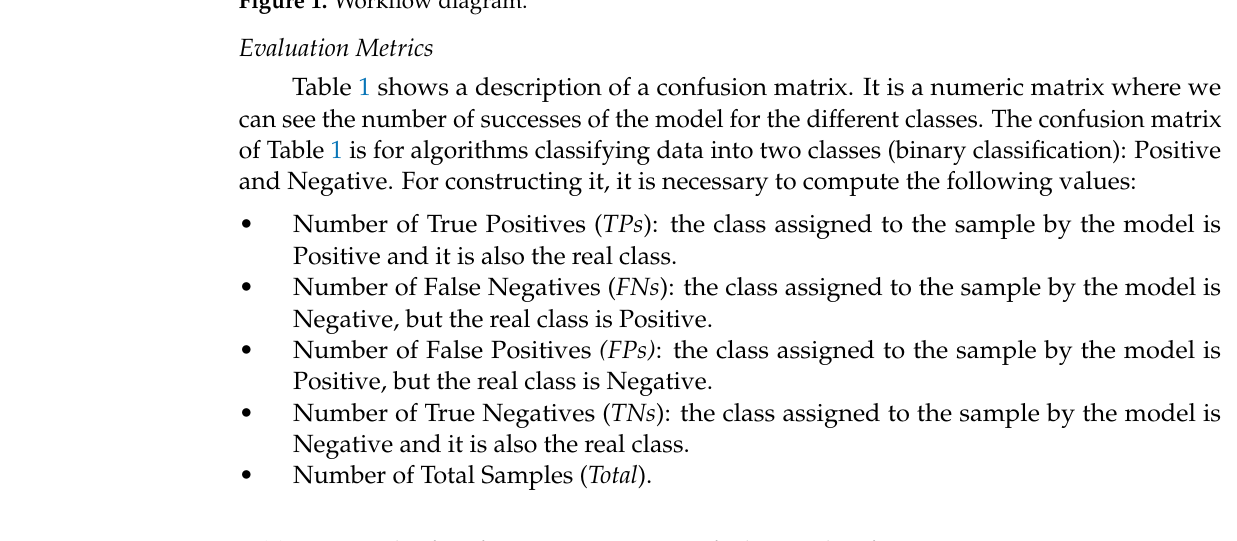
Figure 1. Workflow diagram.